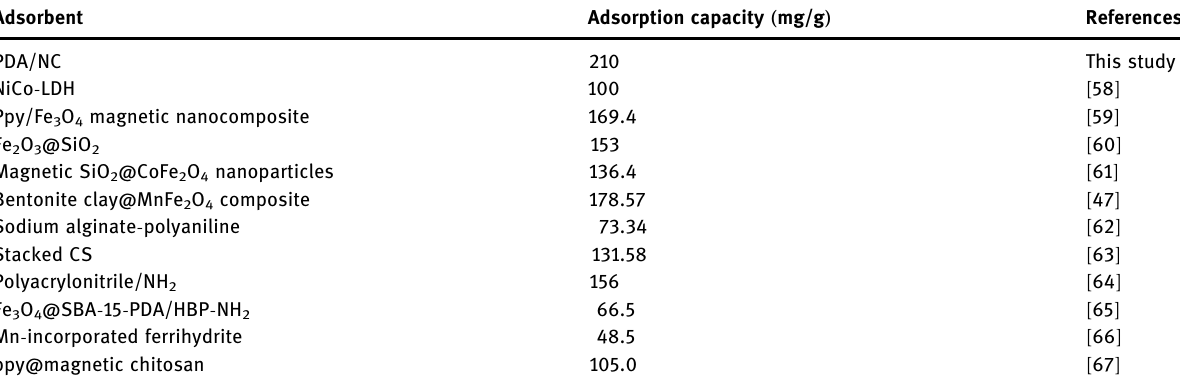
Table 3: The comparison between di ff erent adsorbents for the removal of Cr ( VI ) ions Adsorbent Adsorption capacity ( mg/g